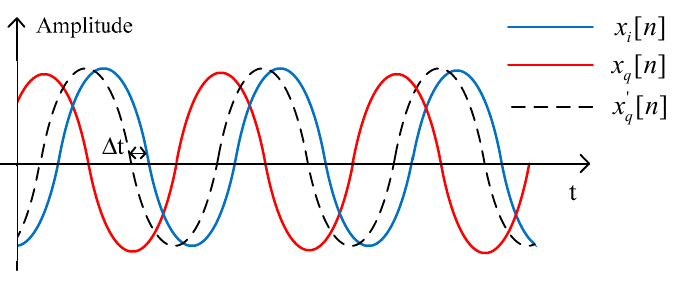
Figure 3. Procedure of Hilbert transform.